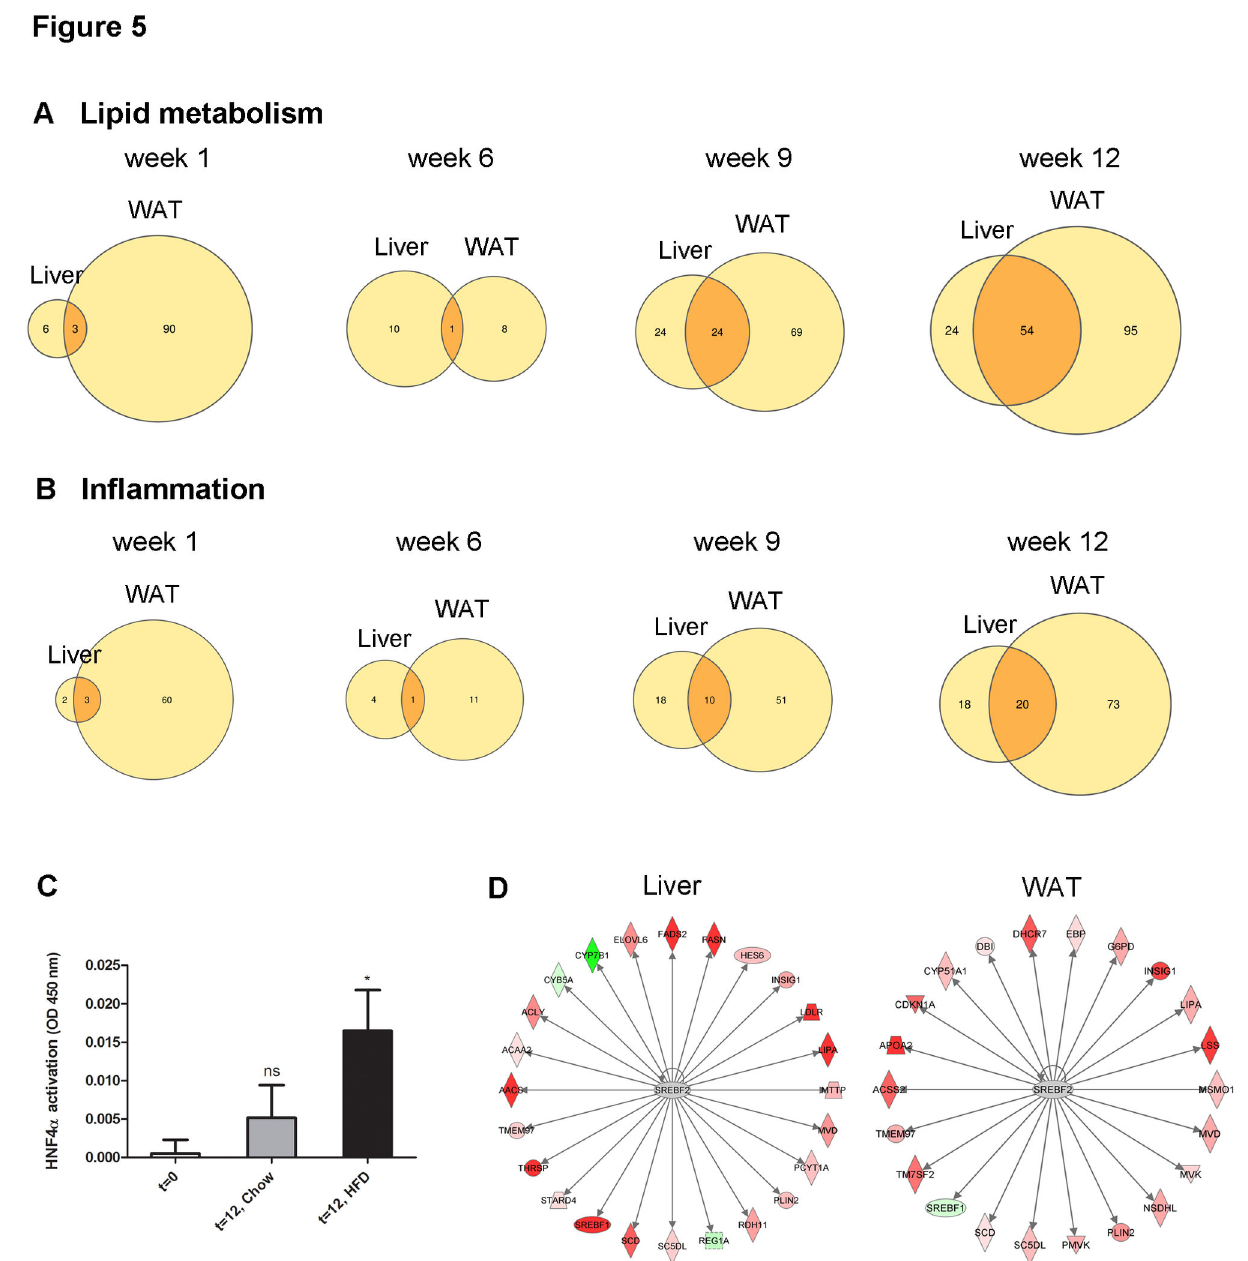
Figure 5. Comparison of gene expression in liver and WAT over time and analysis of transcriptional regulators. Venn diagrams of genes with A , ‘lipid metabolism’ gene ontology or B , ‘inflammation’ gene ontology. Time course analysis of the genes that were differentially expressed genes at a particular time point. The intersection represents the number of ‘overlapping genes’, ie. genes that were affected in both tissues. C , Quantitative analysis of the transcriptional activity of HNF4α by TransAM analysis at t=0 and t=12 weeks of HFD feeding relative to reference mice on chow to correct for aging. *P<0.05. D , Differentially expressed target genes of Srebf2 in WAT and liver. Srebf2 is significantly involved in the control of target genes (P<0.05 for both WAT and liver). In both tissues, the calculated Z-score was positive (3.7 for liver and 4.3 for WAT) indicating that Srebf2 is activated. Genes colored in red (green) are upregulated (downregulated).